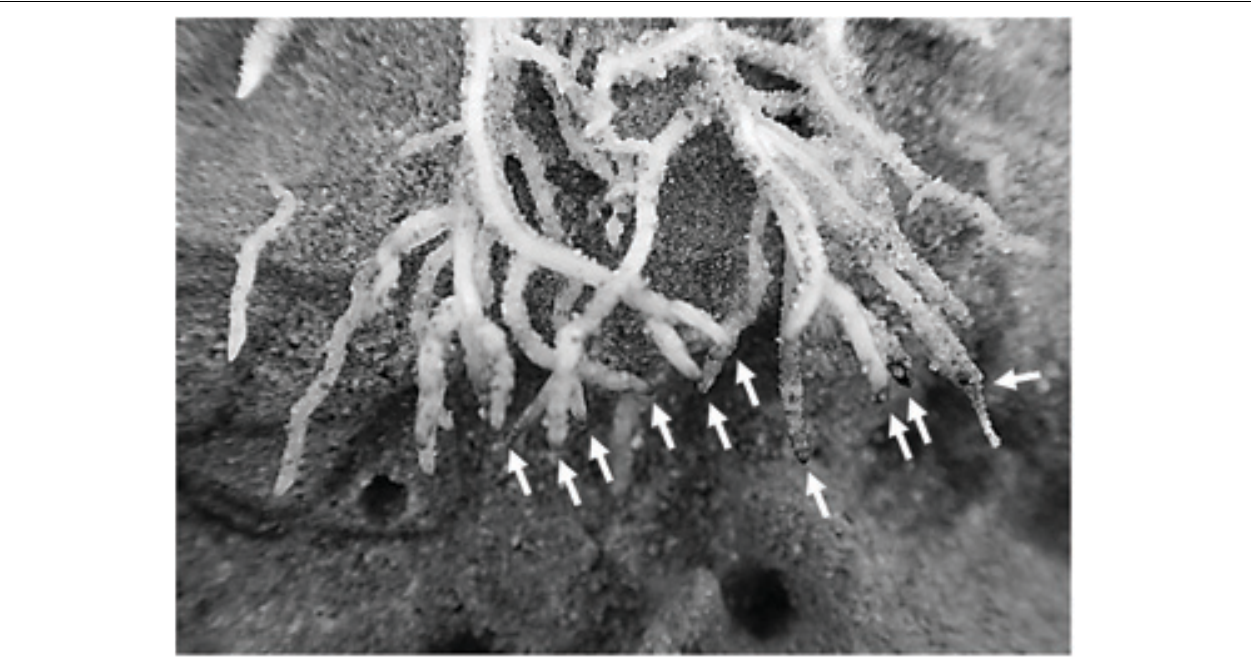
FIGURE 5 | Brown and rotten root tips of S. hermaphrodita grown in digestate depot fertilized rhizotrons occurred in a 6 cm radius around the digestate depot 60 days after planting. Digestate depot fertilization was calculated to simulate a digestate application of 40 t ha − 1 . Arrows indicate the damaged root